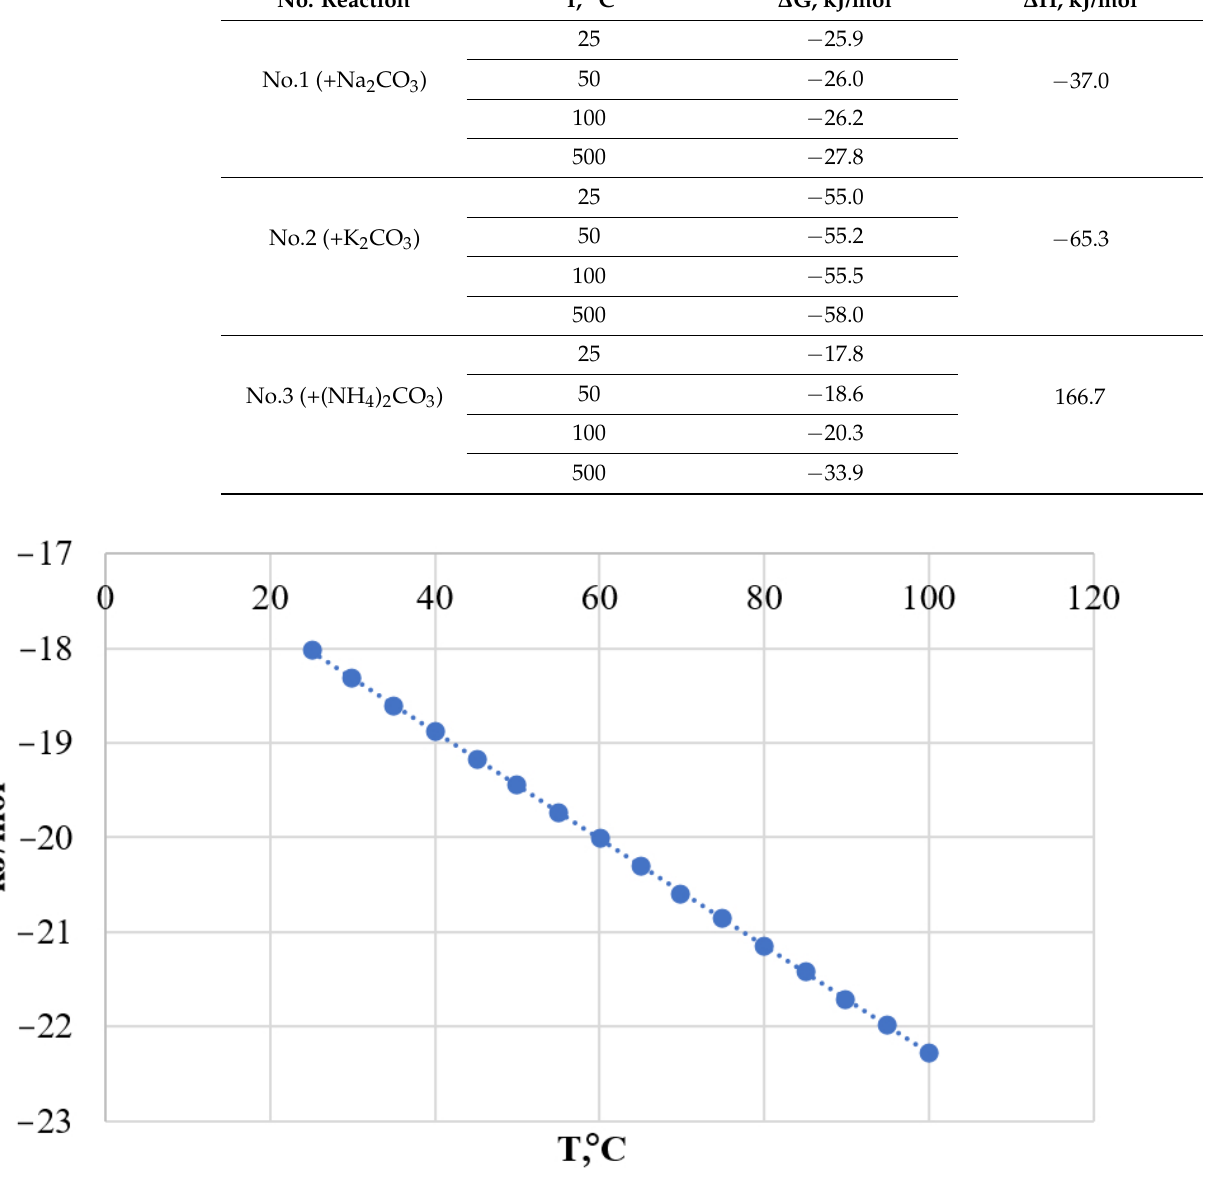
Figure 1. Dependence of Gibbs energy change on temperature.